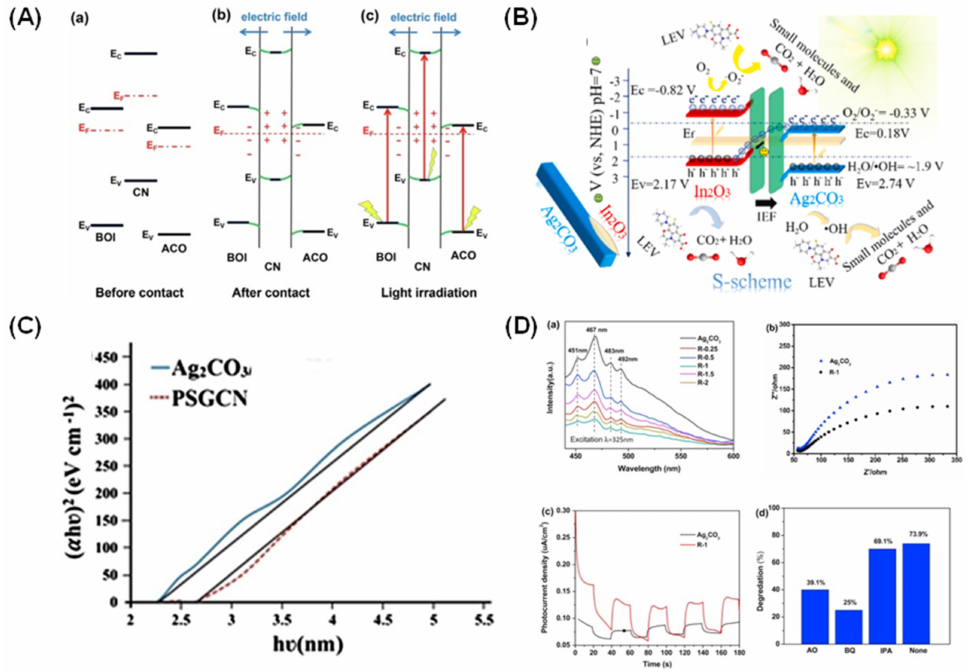
Figure 6. ( A ) Schematic diagram of charge transfer mechanism based on dual S-scheme heterojunction in Ag 2 CO 3 /Bi 4 O 5 I 2 /g-C 3 N 4 photocatalysts. Reproduced with permission from [80]. ( B )